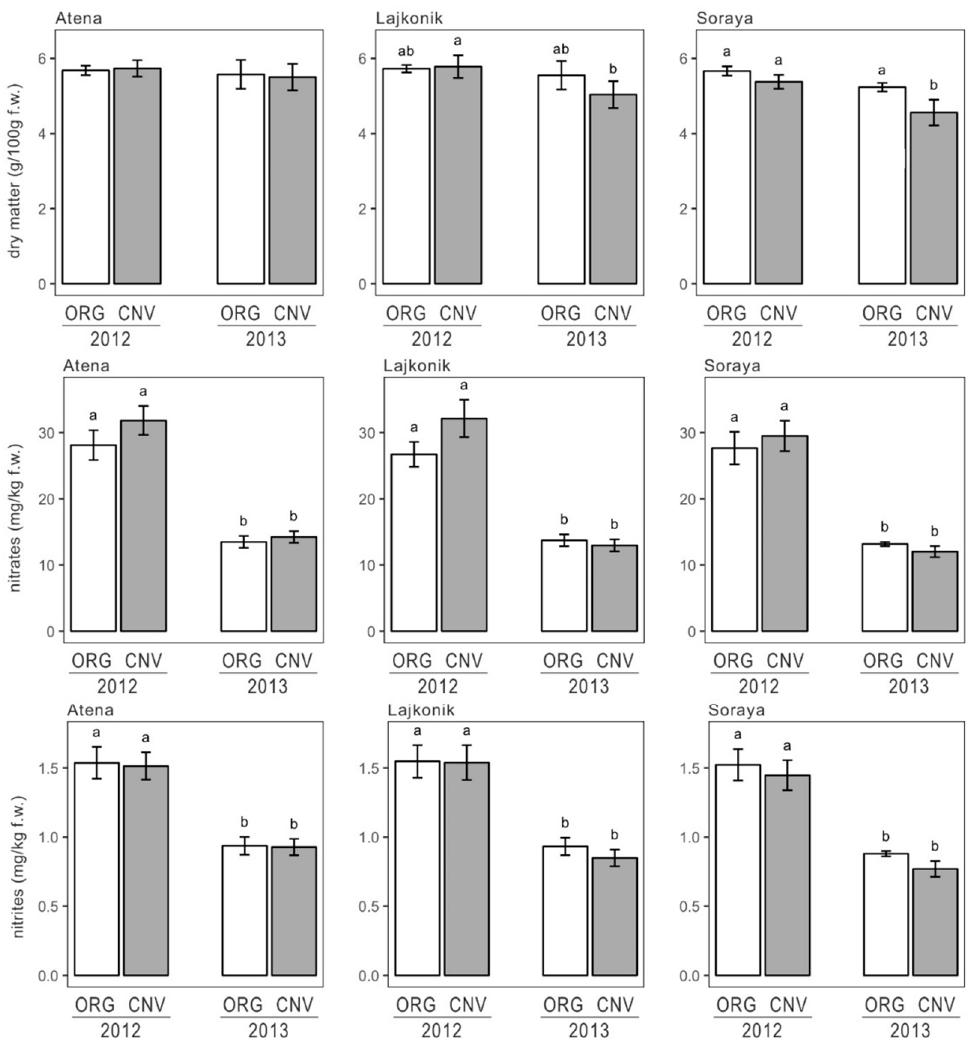
Figure 6. Dry matter, nitrates and nitrites content in organic (ORG) and conventional (CNV) courgette fruits of Atena, Lajkonik and Soraya cultivars grown in two consecutive years. Data are presented as means with standard errors. Within each cultivar, bars marked with the same letters are not significantly different at the 5% level of probability.